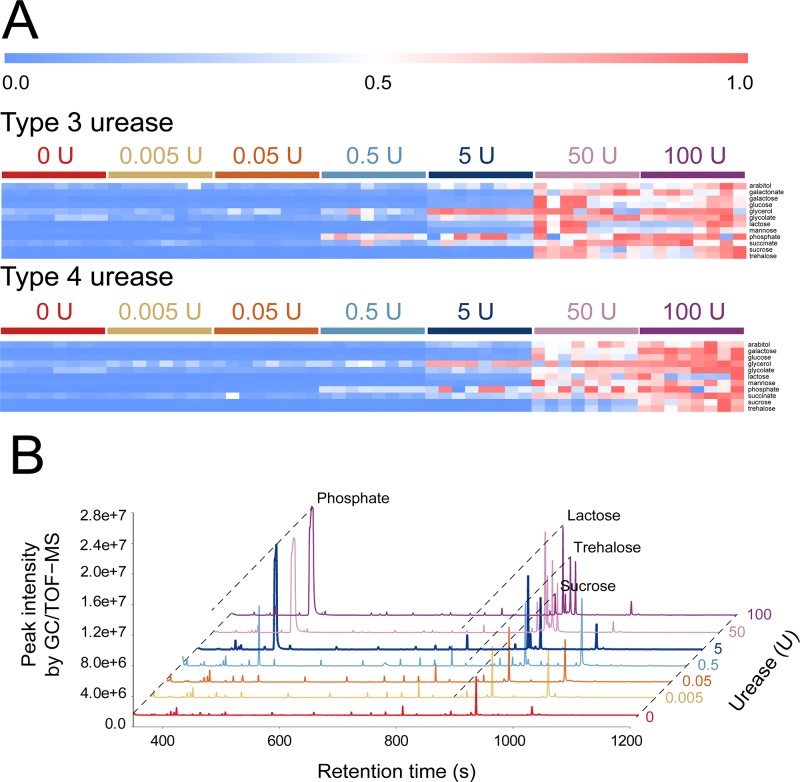
Increases in the abundance of metabolites in response to increasing the loading units (U) of Type 3 and Type 4 ureases.(A) A heat map of the 12 significantly upregulated metabolites that were derived from the Type 3 urease and the significantly upregulated 11 metabolites that were derived from the Type 4 urease, with an increase in the urease loadings (p < 0.05, according to the Kruskal–Wallis test with FDR adjusted via the Benjamini–Hochberg correction). (B) Total ion chromatograms for different loading units (U) of the Type 3 urease.